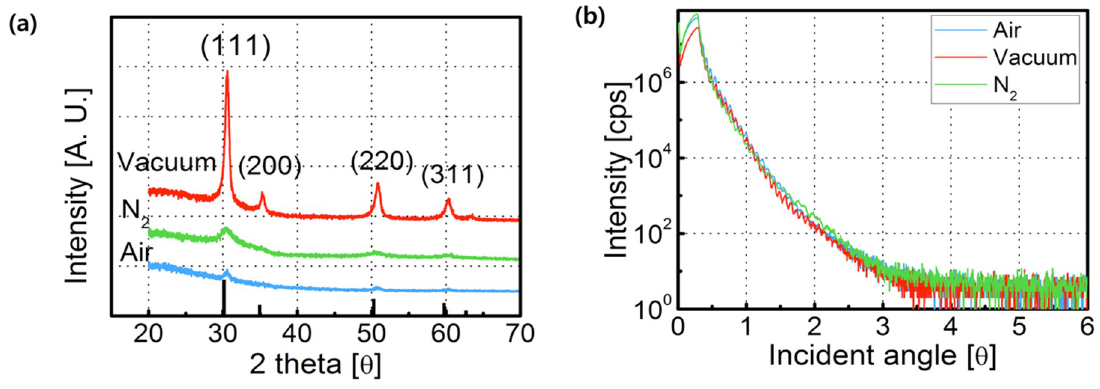
Figure 1. ( a ) XRD results of sol–gel-processed ZrO 2 films and ( b ) XRR results of ZrO 2 films annealed in air, vacuum, and N 2 .